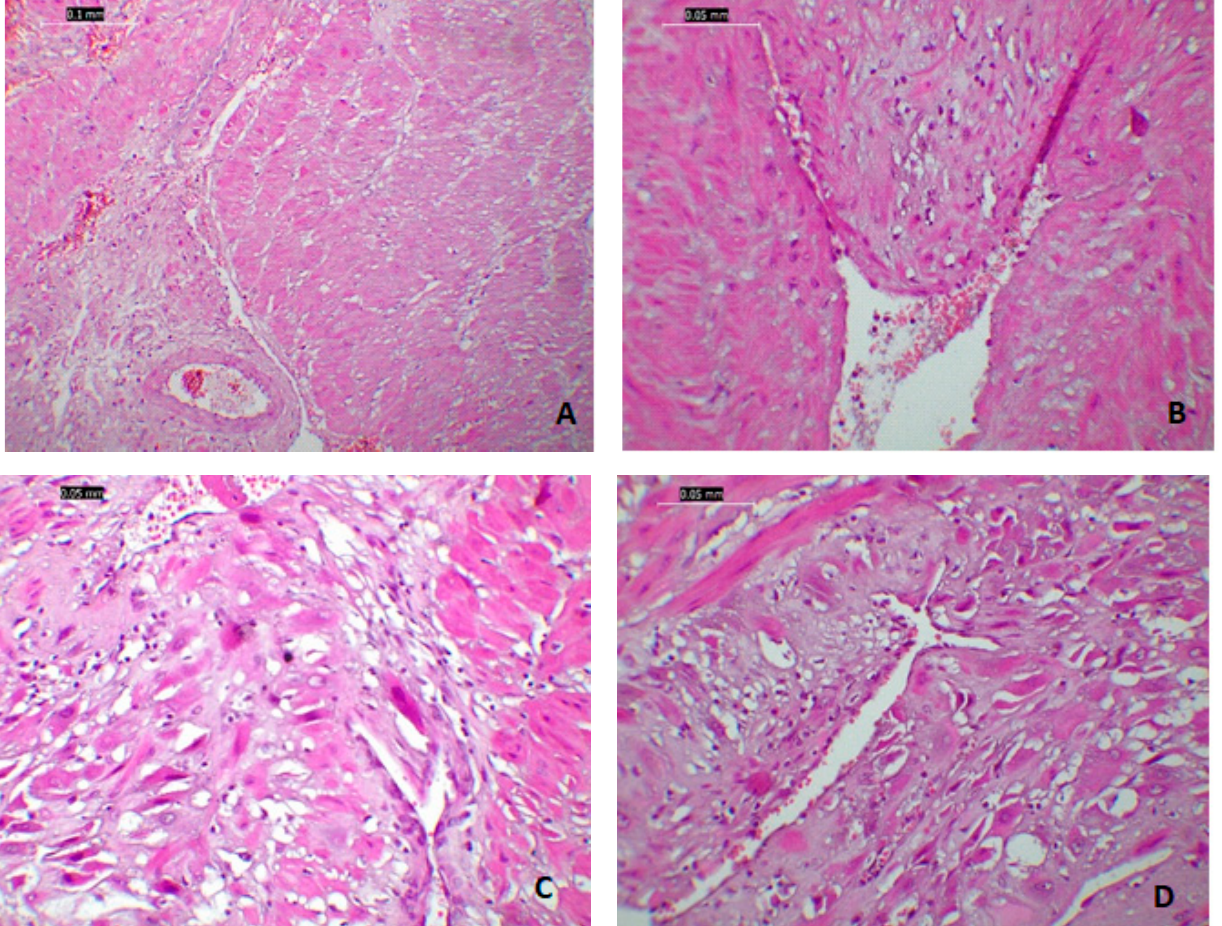
Figure 2. Histological modifications of the miometrium in a patient with SARS-CoV-2: ( A ) microphotography (4×) of the miometrium with diffuse oedema predominantly located in the perivascular areas; ( B – D ) interstitial blood suffusion as well as marked difference in celular coloration due to cellular